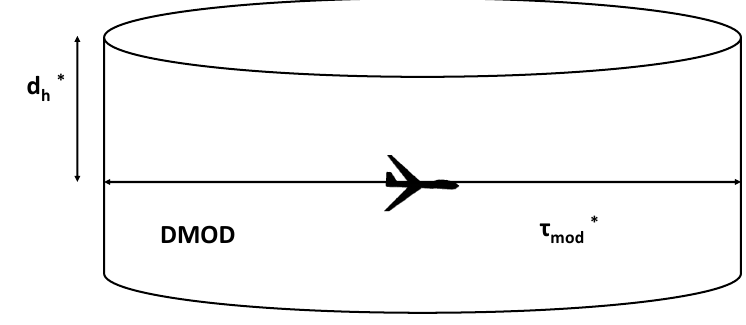
Figure 2. Well clear volume representation.